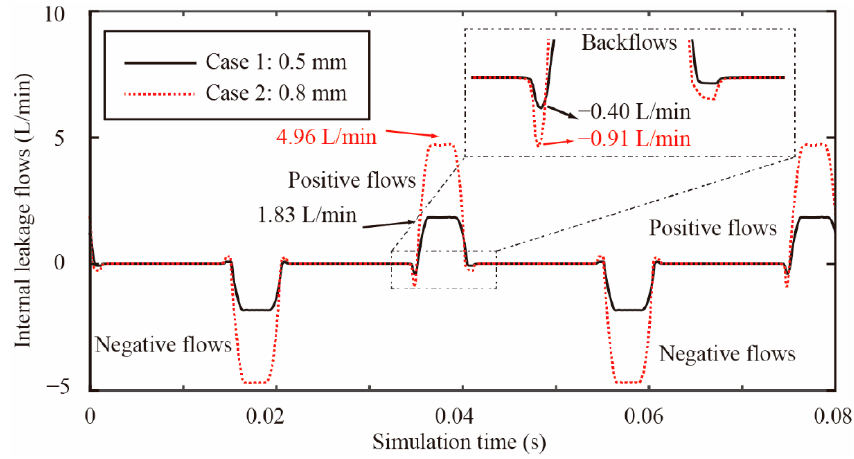
Figure 9. Internal leakage flows of the slender hole.